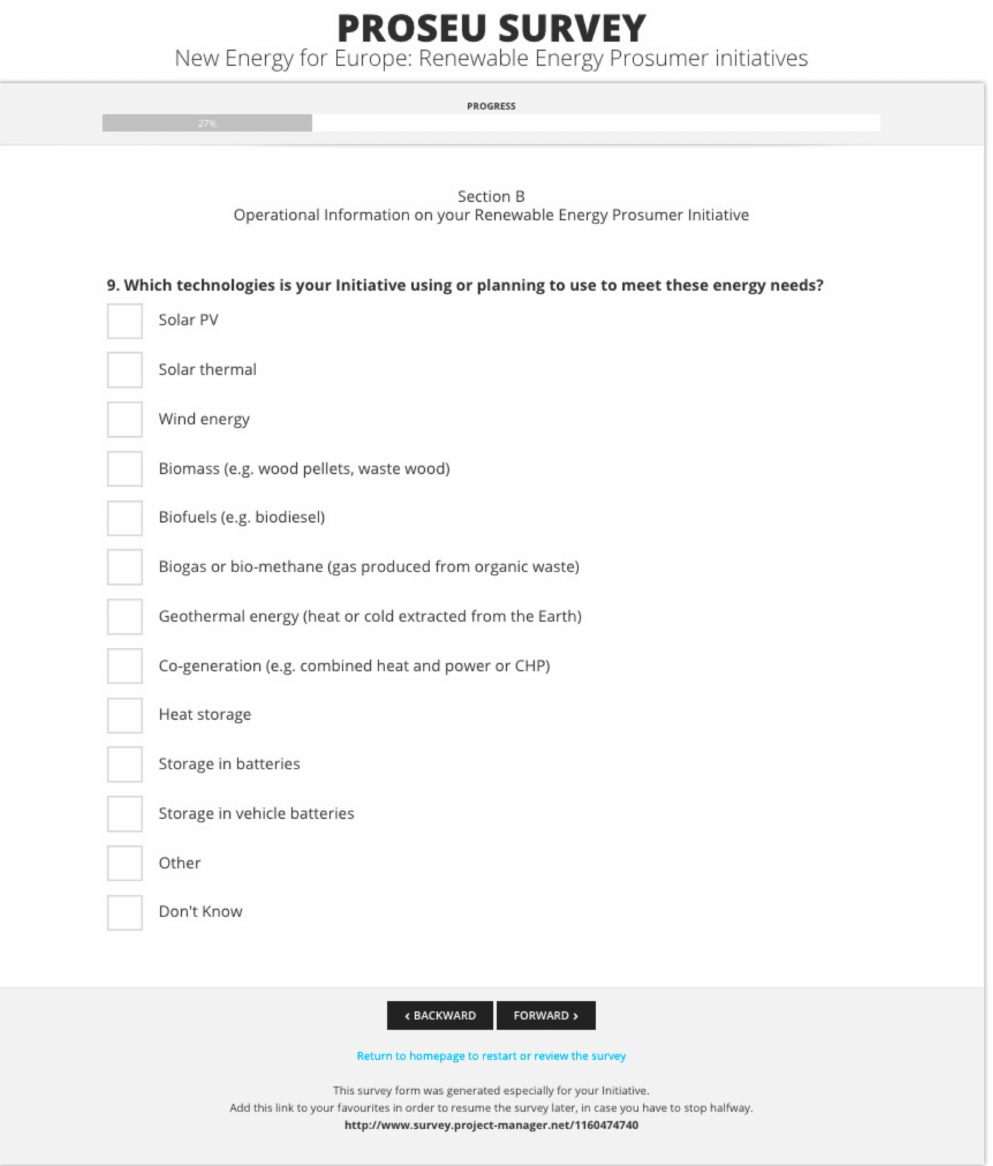
Figure A2. Question 9 of the survey